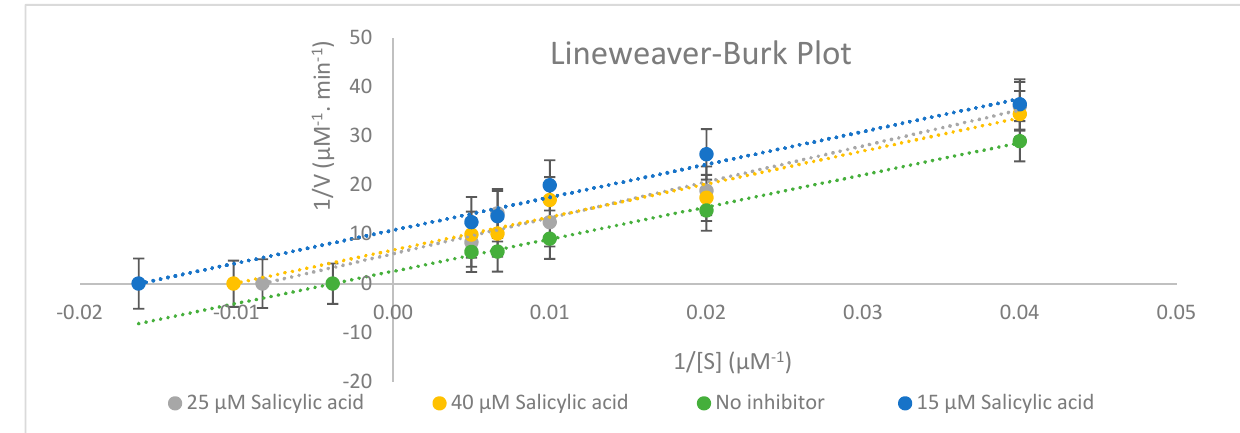
10 of 15 Table 11. Stability test outcome of testosterone glucuronide. Stability Test Parameters 108.65 a % Recovery = (theoretical concentration of testosterone glucuronide at Day 2)/theoretical concen- tration of testosterone glucuronide at Day 1) ×100. b Accuracy = 100 − ((theoretical concentration − actual concentration)/actual concentration) ×100. The results illustrate that the concentration of testosterone glucuronide and the chro- matographic peak area were consistent between Days 1, 2, and 3. Calibration curves were plotted for 0, 48, and 72 h, and thus, the average calibration curve equation for the three days was: y = 0.012x − 0.0134 (standard error = 0.004/intercept = − 0.010), (R 2 = 0.999) (Figure S4). Based on Figure S3 results, percentage accuracy and recovery fall within the accepta- ble ICH guidelines (80–120%). The results revealed that testosterone glucuronide was sta- ble for three days at normal ambient conditions [12]. 2.4. In Vitro Potential Assessment of UGT2B17 Enzyme Activity Inhibition by Salicylic Acid To assess the potential UGT2B17 enzyme activity inhibition by salicylic acid in hu- man supersomes, different salicylic acid concentrations levels (0, 15, 25, and 40 µ M) were incubated at 37 °C with different concentrations of UGT2B17 substrate testosterone (25, 50, 100, 150, and 200 µ M). The standard incubation mixture for each reaction tube con-